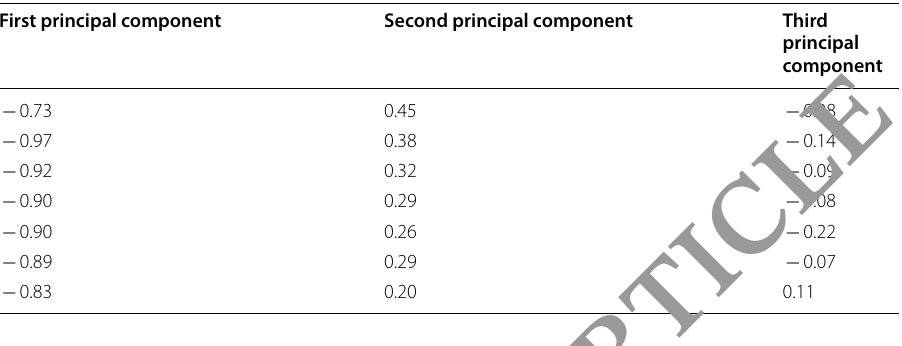
Table 7 Principal component